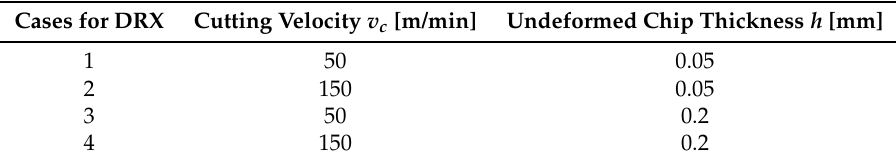
Table 7. Hard turning experimental conditions for DRX-model verification [39].